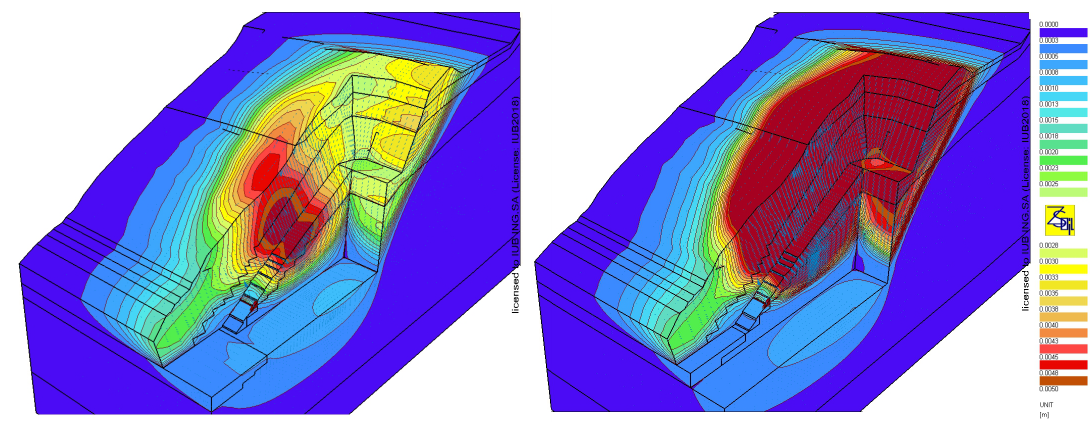
Figure 8. Beginning failure of pit at the last-but one excavation step (left), loss of convergence during the last excavation step (right); colours of abs. displacements as before.